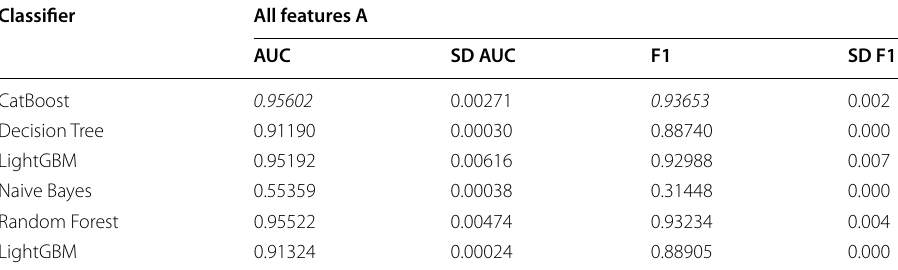
Best metrics are highlighted in italics; SD AUC is the standard deviation of AUC and SD F1 is the standard deviation of the